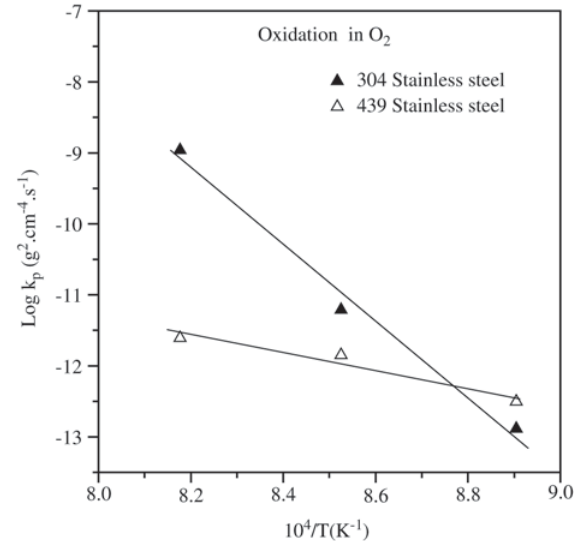
Figure 10. Arrhenius plot of the parabolic oxidation constants of 439 steel in oxygen and in Ar-H